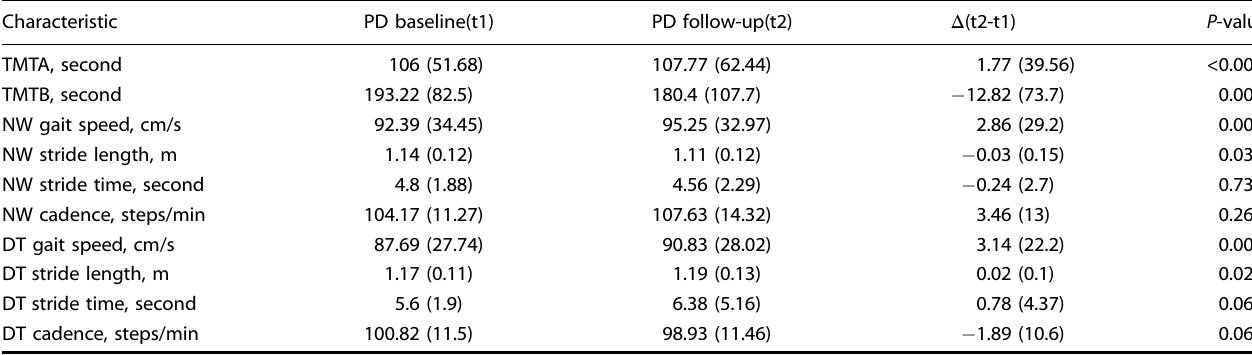
Table 2. Gait and cognitive performance scores of the PD group before and after TT.